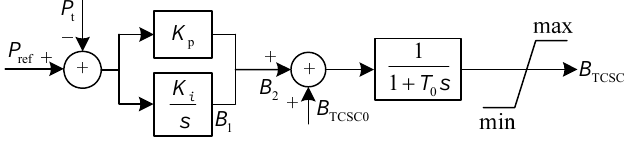
Figure 2. Dynamic model of TCSC.